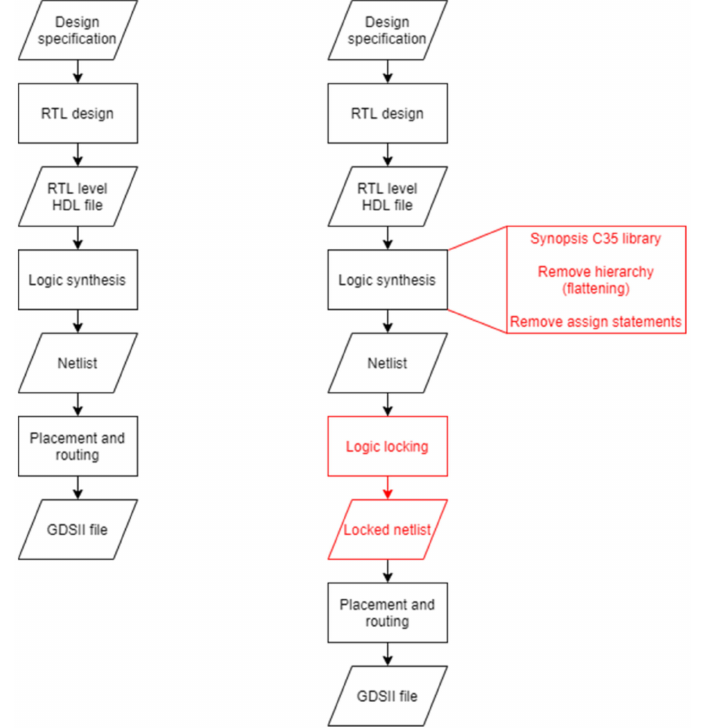
Figure 11. A typical IC design flow ( left ) and IC design flow with logic locking ( right